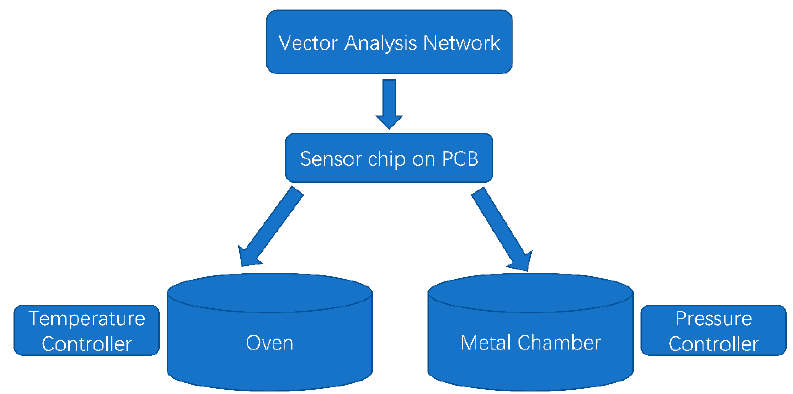
Figure 13. The schematic of the Lamb wave pressure sensor temperature and pressure character testing system.